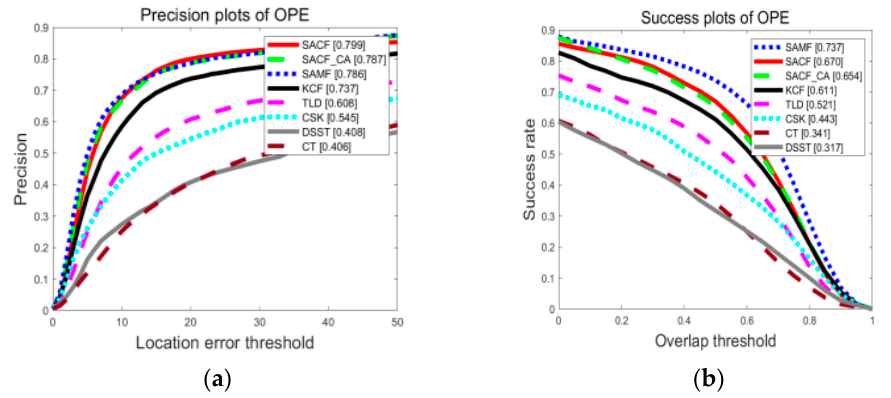
Figure 3. Distance accuracy and success rate curves of eight algorithms in OTB-2015. ( a ) Location error threshold. ( b ) Overlap threshold. error threshold. ( b ) Overlap threshold.